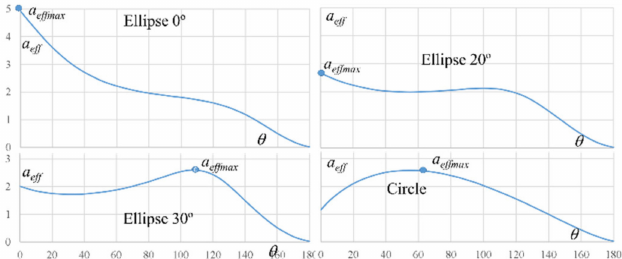
Figure 22. a eff for the circular and elliptical trochoidal